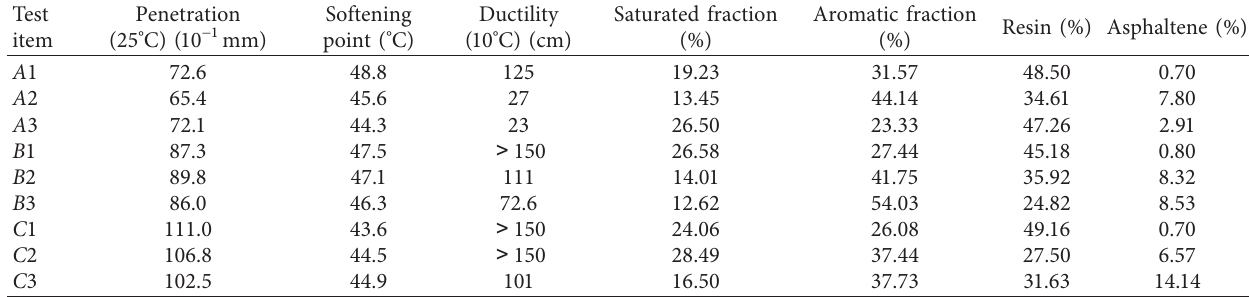
Table 1: Technical indices and chemical components of the matrix asphalt.